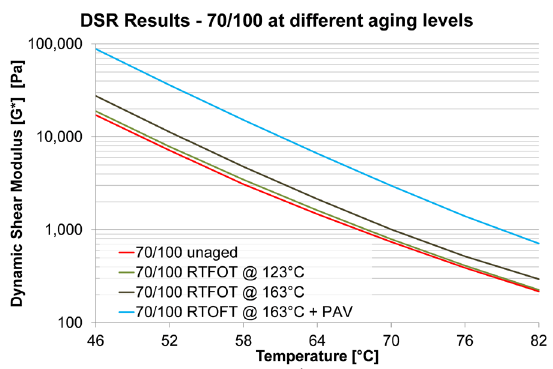
Figure 3 . DSR results for Bitumen 70/100 at different aging levels.